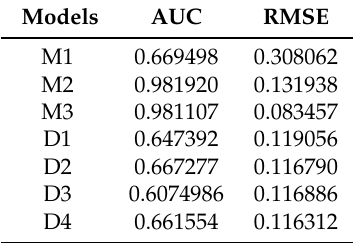
Table 8. Performance for the seven models using the top 10 features from model D1 on the test